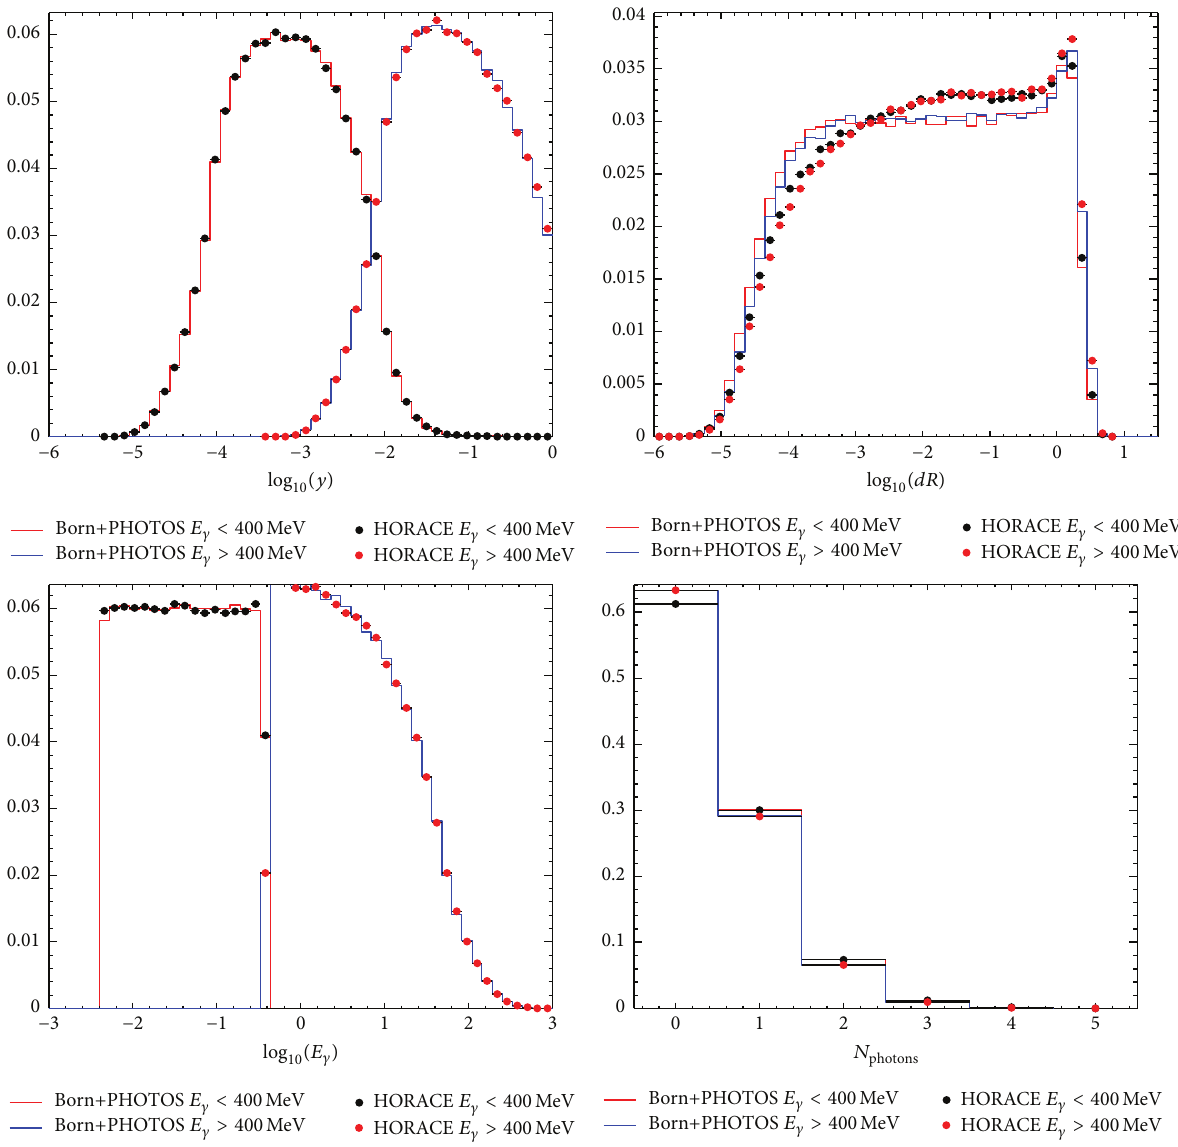
Figure 2: Clockwise from top-left: comparisons of the distributions of log 10 (𝑦 𝛾 ) , log 10 (Δ𝑅(𝑙𝛾)) , 𝑛 𝛾 , and log 10 (𝐸 𝛾 / GeV) for the 𝛾 ∗ /𝑍 → 𝑒 + 𝑒 − + 𝑛𝛾 process between the “Born” mode of old horace interfaced with photos and old horace in the exponentiation mode. The comparisons are shown separately for low ( 𝐸 𝛾 < 400 MeV) and high-energy ( 𝐸 𝛾 > 400 MeV) photons. The smaller of the two Δ𝑅 values with respect to the two electrons is